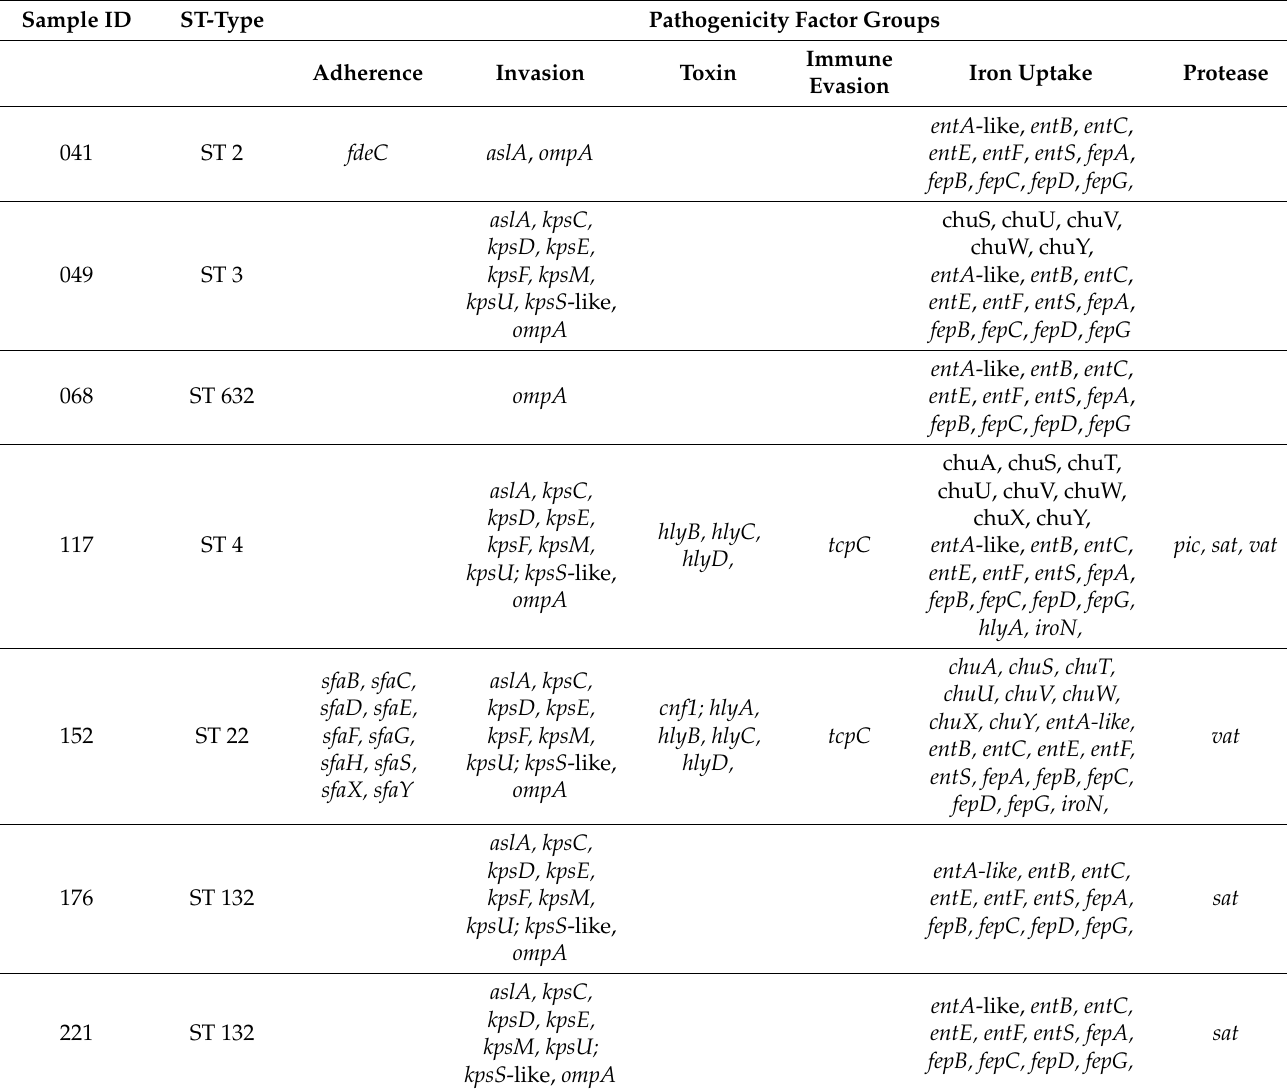
Table 2. Analysis of virulence determinants, ordered by strain and MLST type, of the assessed E. coli isolates. ST = Sequence type. Sample